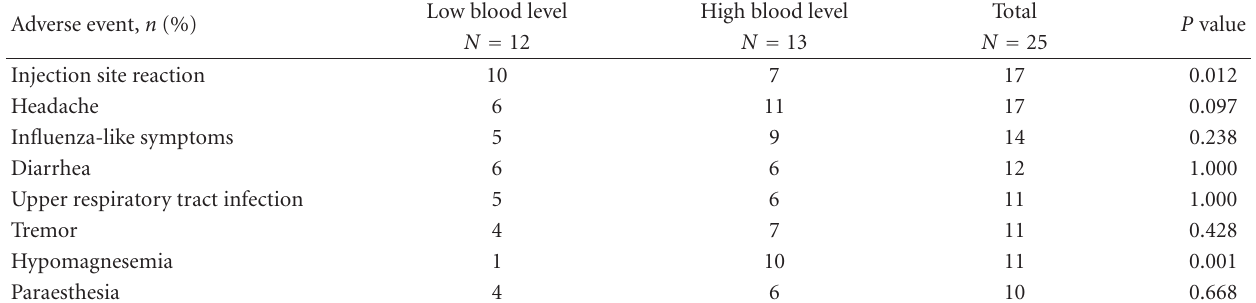
Table 3: Adverse